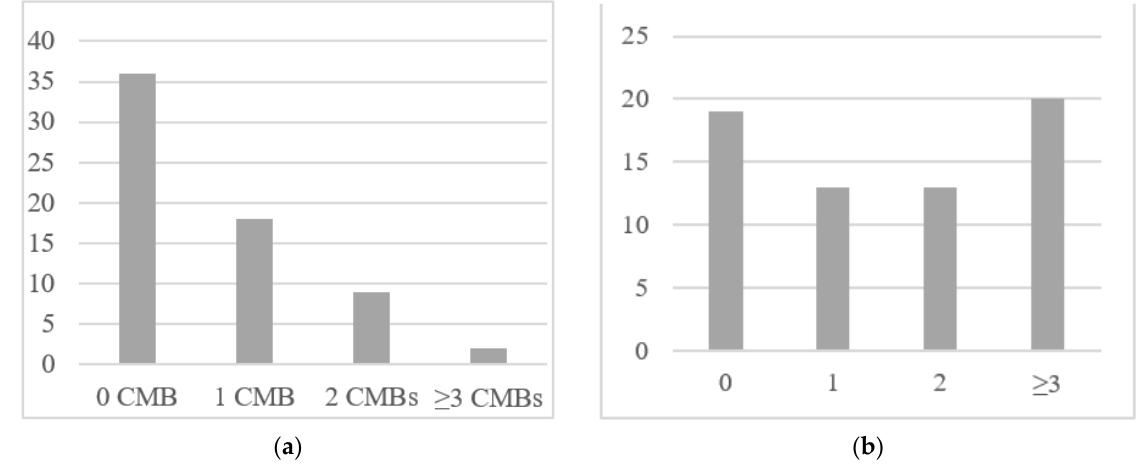
Figure 2. ( a ) Frequency of comorbidities (CMB) in the cohort of patients. ( b ) Frequency of number of drugs regularly assumed by HCV/HIV co-infected patients (ART not included).